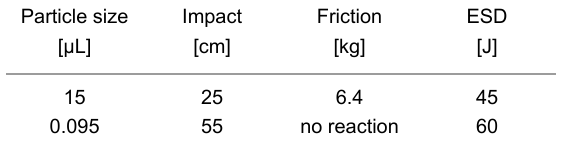
Table 3: Comparison of the sensitivity levels of micrometer and nano- meter-sized CL-20 [4].